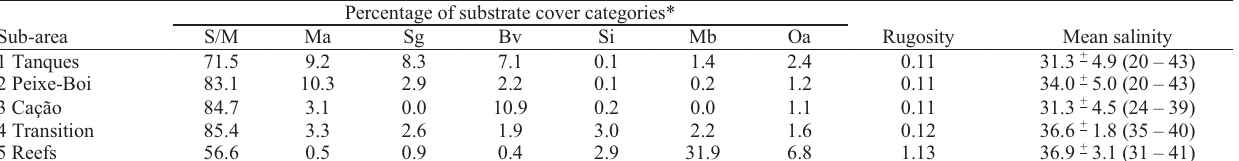
Table 5. Percentage of substrate cover (main items), rugosity index and salinity (mean + standard deviation and variation) along the Mamanguape Mangrove-Reef system, Paraíba, NE Brazil, according to the sampling sub-areas from October 2007 to September 2008. *. Cover categories: S/M - sandy or muddy bottom, without visually detectable organisms; Ma - Mangrove roots, leaves and fallen branches of mangrove trees, mainly Rhizophora mangle ; Sg - Seagrass beds, Halophila sp. and Halodule wrightii ; Bv - bivalve shells, mainly Crassostrea rhizophorae , Anomalocardia brasiliana , and Lucina pectinata ; Si - Sessile invertebrates, sponges, including Haliclona sp., Cinachyrella alloclada , and cnidarians, including Carijoa sp.; Mb - Macroalgae beds, red algal beds, mainly composed by Hypnea musciformis , Hypnea spinella , Cryptonemia sp., and Acanthophora sp.; Oa - Other algae, drifting or attached algae (not forming beds), which included Gracilaria sp., Gelidiella acerosa , Pterocladia sp., Gelidium sp., Corynomorpha sp., and Acetabularia sp.